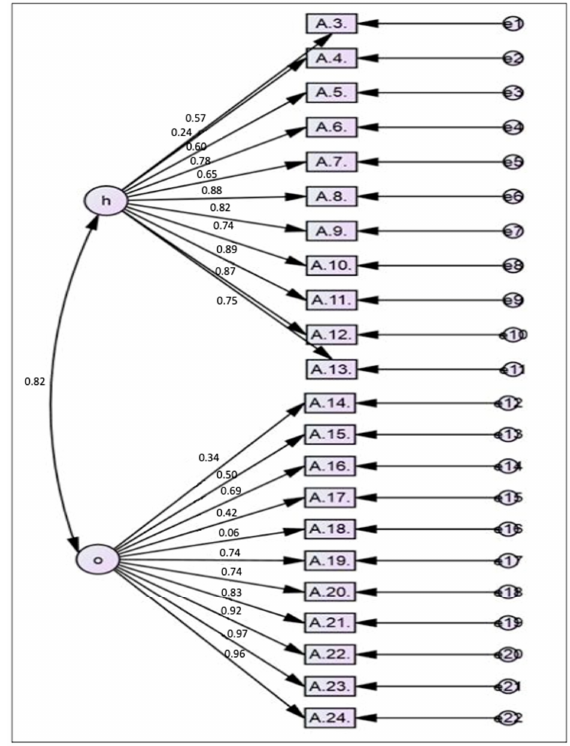
Figure 1. First model of the AAAQ containing 22 items